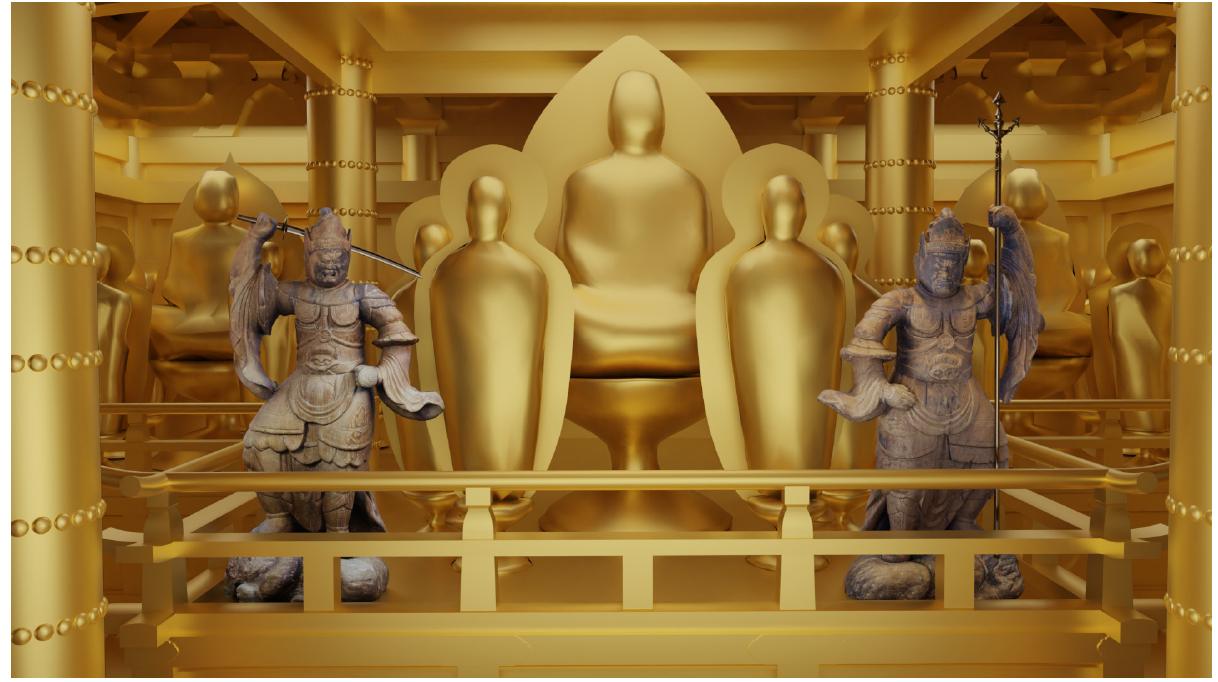
Figure 6 . Location of the guardians within the statuary complex inside the Gold Colored Hall. Modelling: S. Tamantini. The Ni-Tennō are often identified with Zōchōten, guardian of the South, and Jikokuten, guardian of the